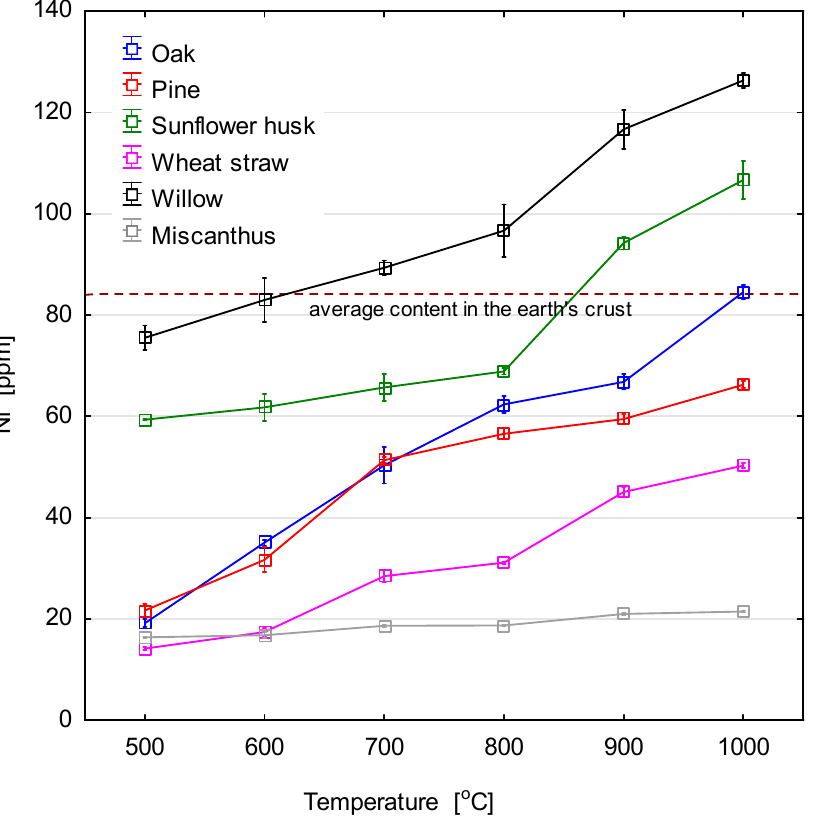
Figure 6. Changes in Ni content in the examined biomass depending on ash-forming temperature.